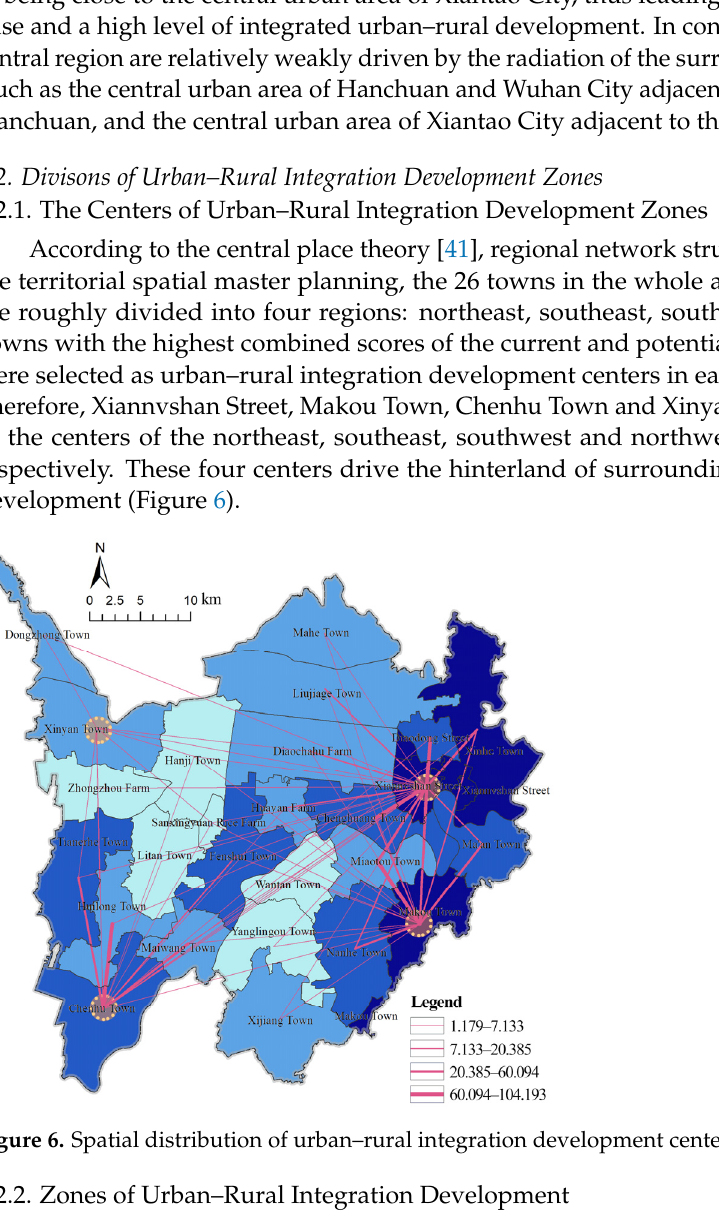
Figure 5. Spatial distribution of the comprehensive evaluation results of urban–rural integration development.